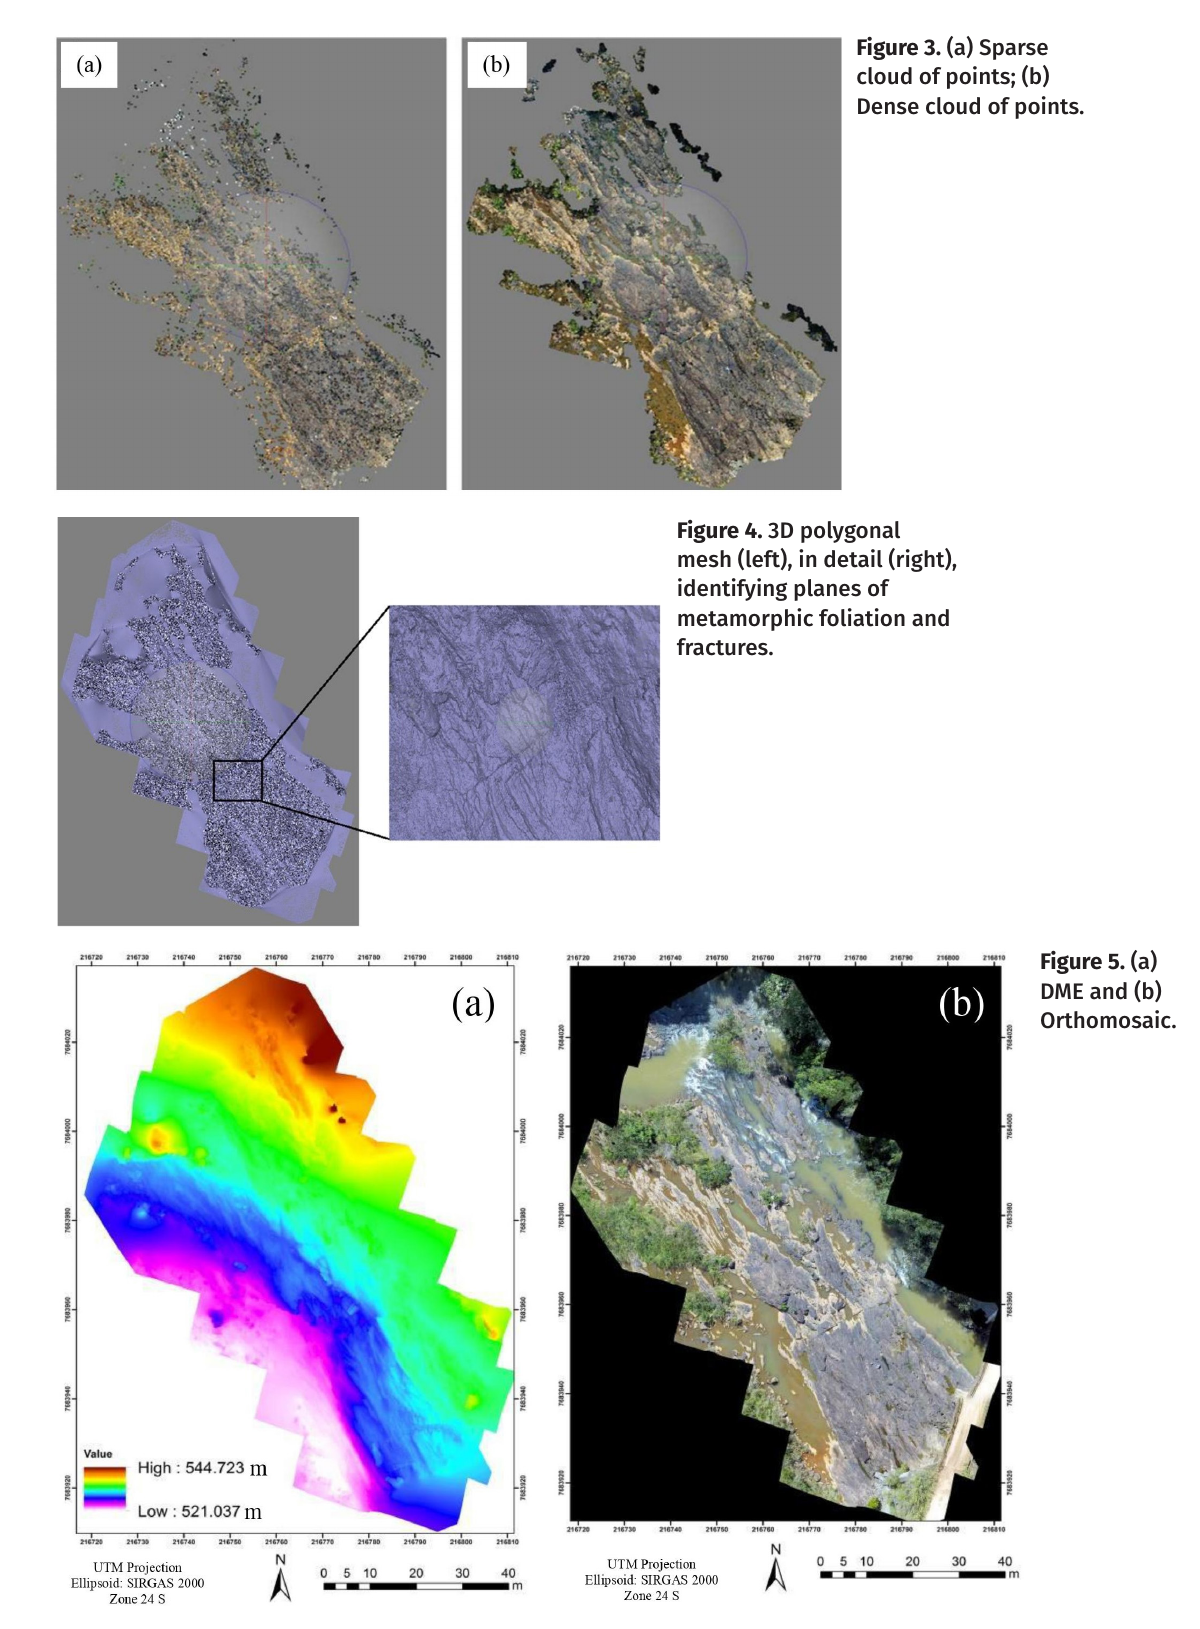
Figure 4. 3D polygonal mesh (left), in detail (right), identifying planes of metamorphic foliation and